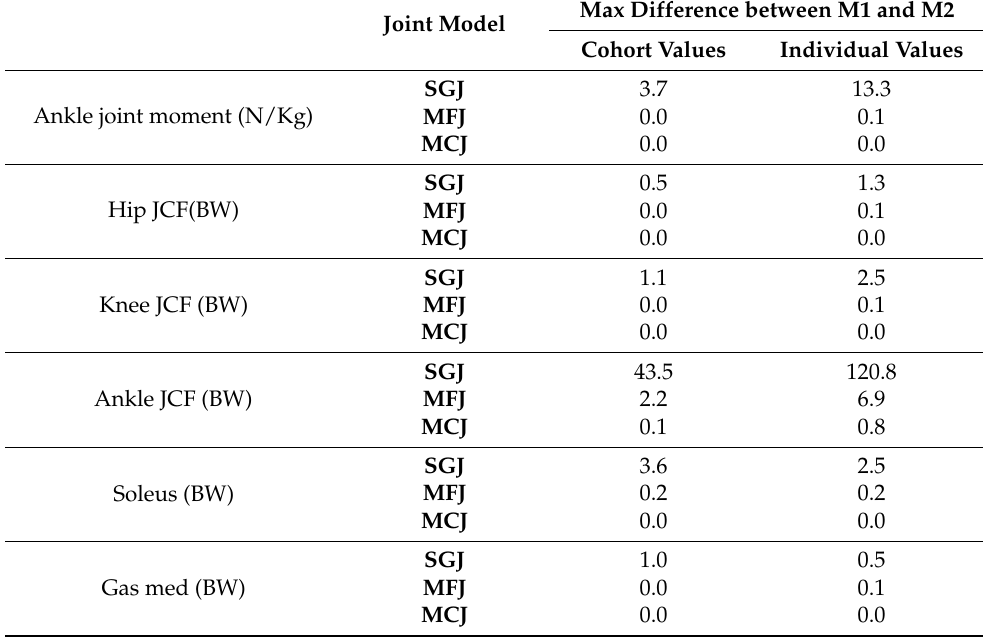
Table 2. Maximum ligaments elongations and cartilage co-penetration over the ROM for the average cohort and